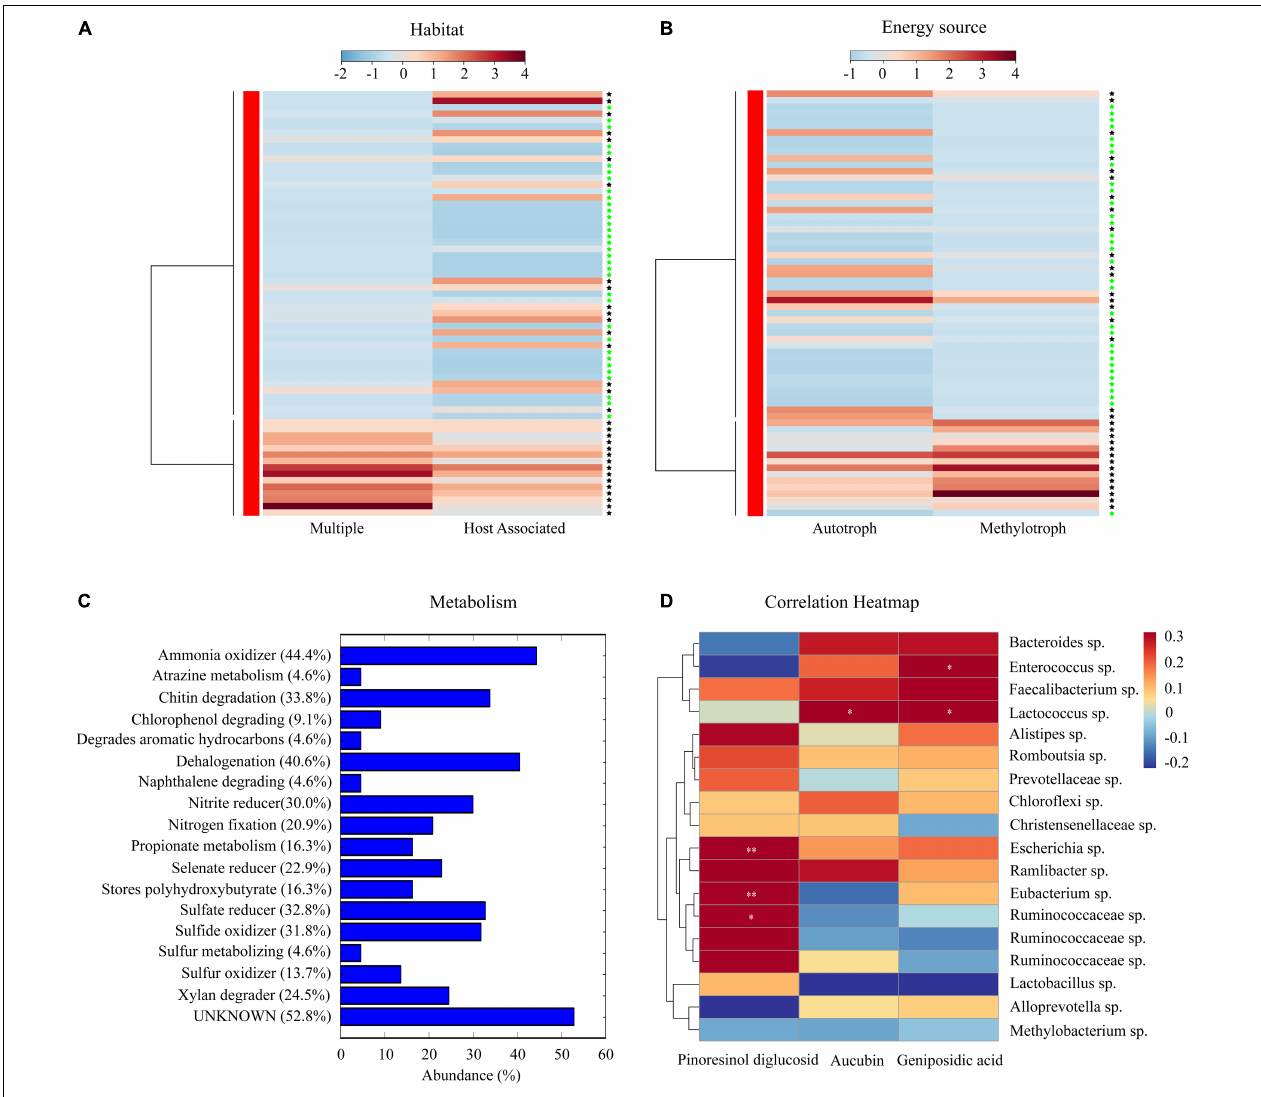
FIGURE 5 | Phenotypic characteristics and potential metabolic functions of the core microbiota of E. ulmoides . (A) Habitat information of the core microbiota. (B) Energy source of the core microbiota. (C) Potential metabolism of the core microbiota. (D) Heatmap of the correlation between core microbiota and active compounds. The “black asterisk” represents rhizosphere soil samples, “green asterisk” represents bark samples. Significance levels were ∗ p < 0.05, ∗∗ p <